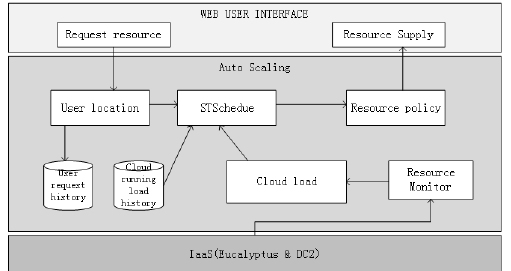
Table 1. Prototype system configuration information